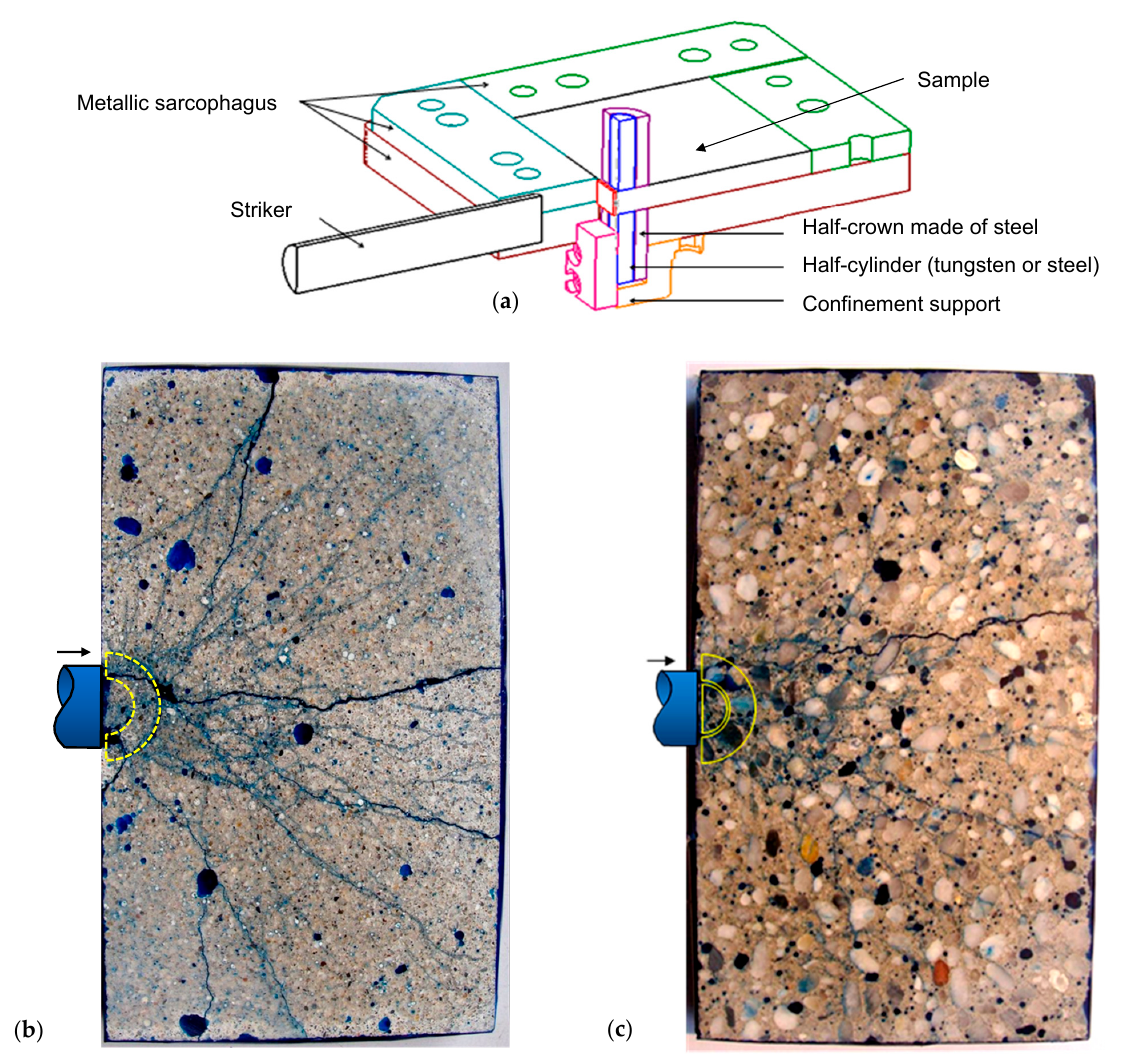
Figure 7. Edge-On Impact testing method applied to concrete. ( a ) Cut-view of EOI set-up in sarcophagus configuration [7], ( b ) Dry microconcrete tested in sarcophagus configuration [20], ( c ) Dry common concrete tested in sarcophagus configuration [9].